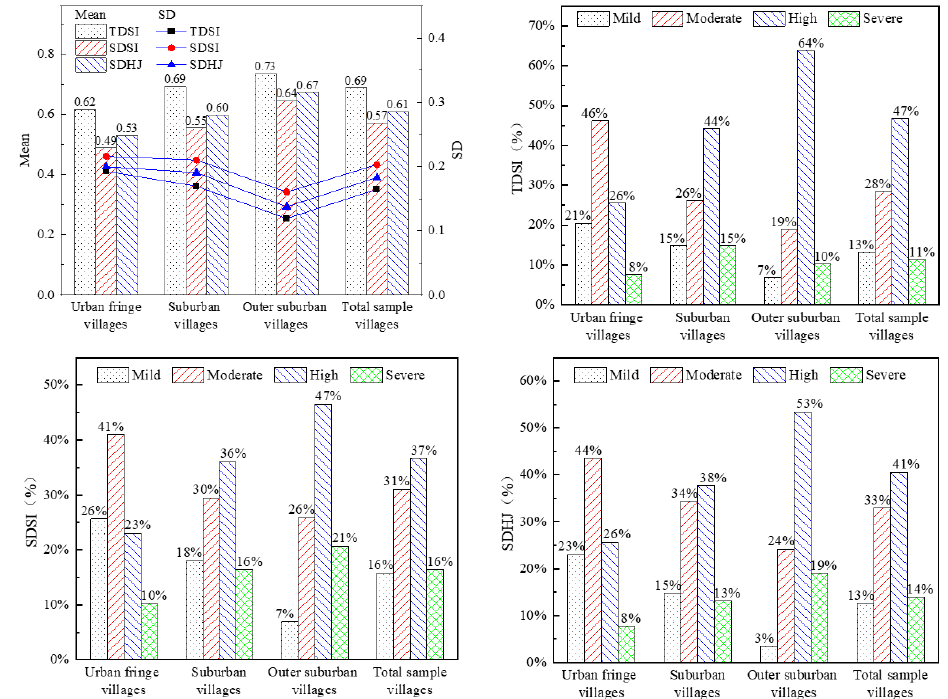
Figure 4. Statistical analysis of TDSI, SDSI, and SDHJ of various village types.